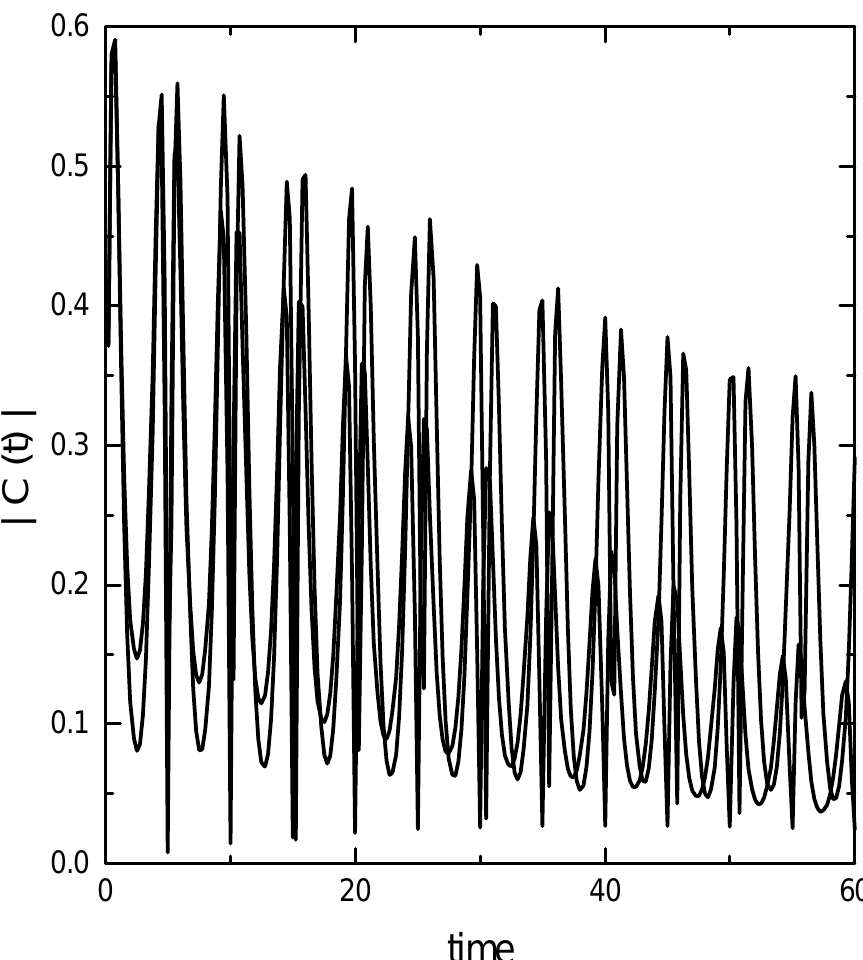
Fig.1: Modulus of the Raman kernel for the fundamental transition. (Continous line – converged basis set calculation; dash-dotted line - coupled cluster